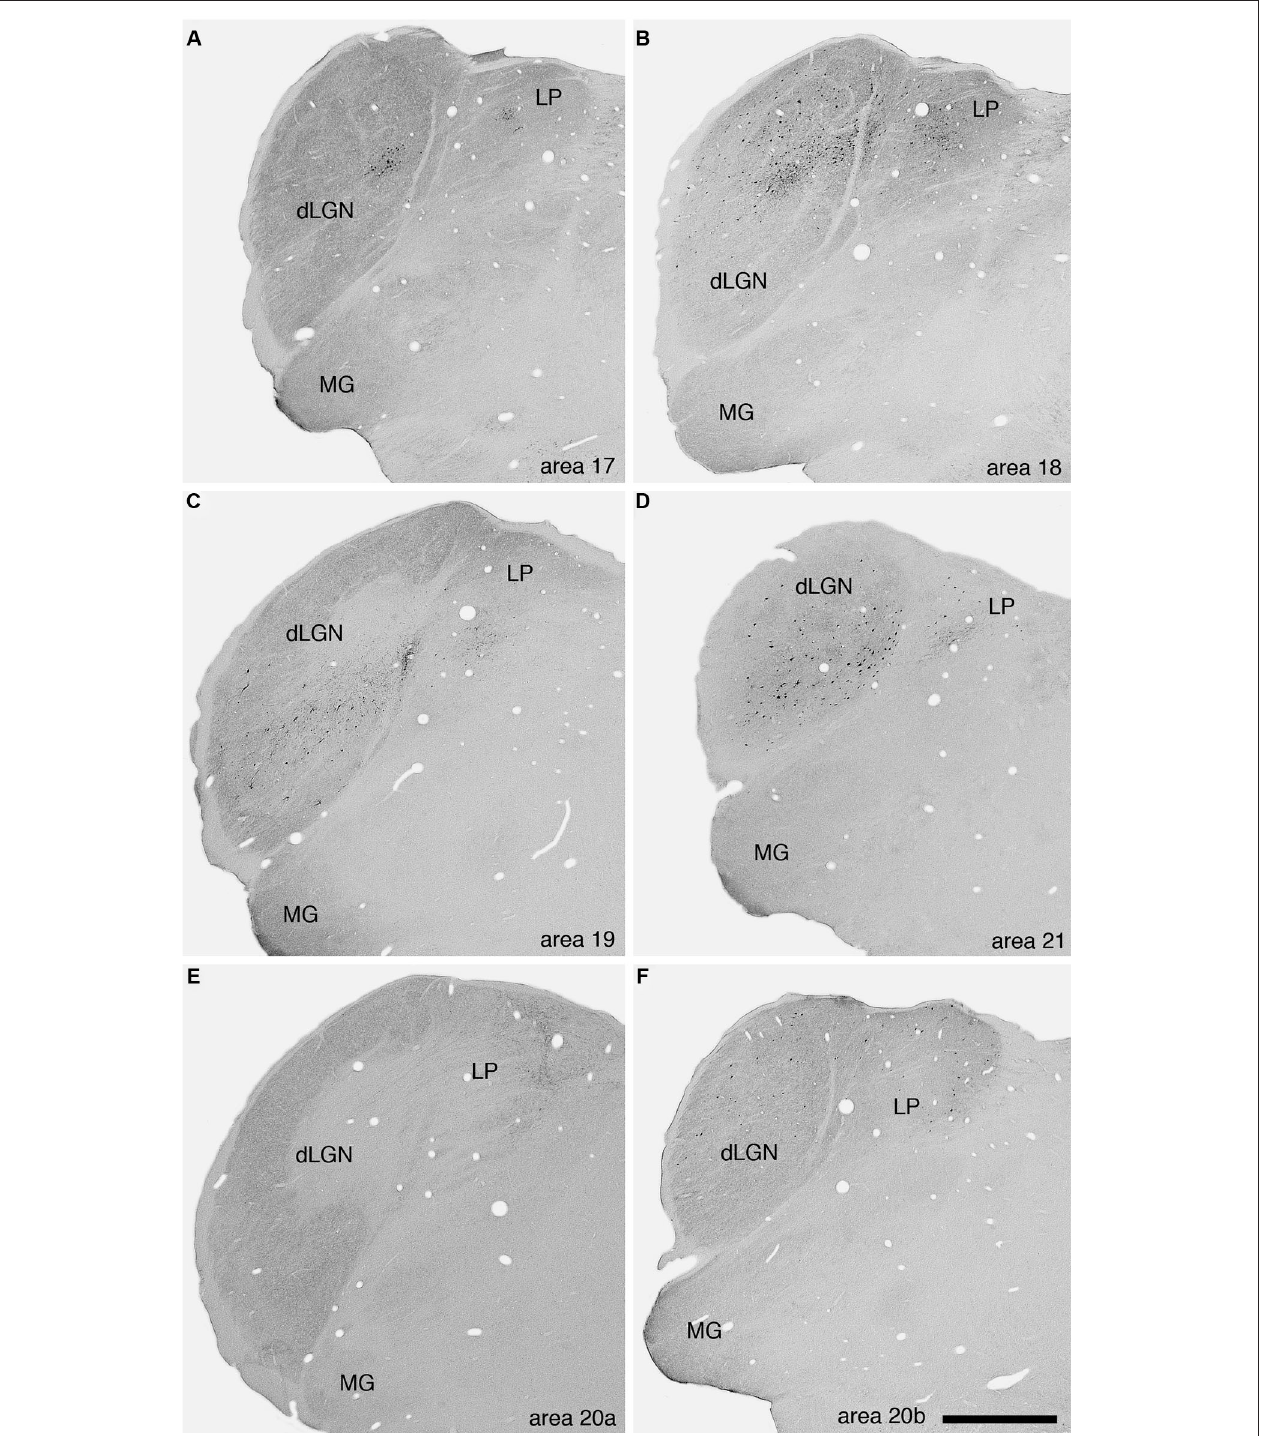
axon terminals in the dLGN or the lateral posterior nucleus ( LP ) following the injections into the different cortical areas. Scale bar in F = 1 mm and applies to all. Dorsal to the top and medial to the right in all images. MG— medial geniculate